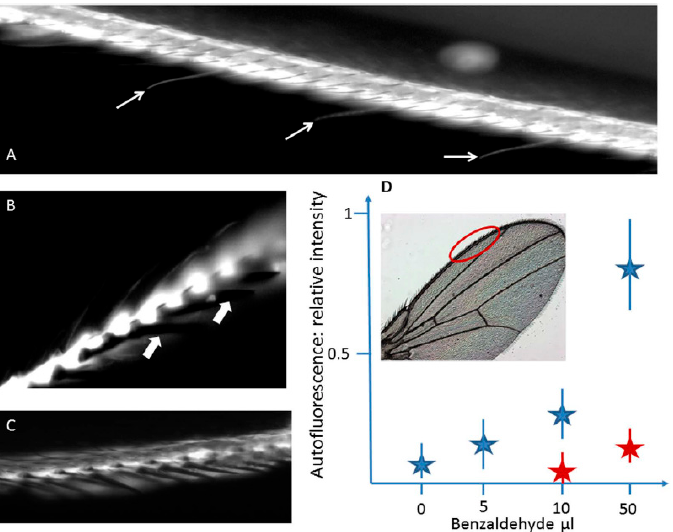
Figure 5. Treatment with volatile benzaldehyde results in the appearance of strong fluorescence emission in the regions of the wing of Drosophila corresponding to ( A ) the anterior margin of the vein, where also chemosensory sensilla are labelled (arrows), and ( B ) the chemosensory hairs, contrarily to the mechanoreceptors bristles (arrows). ( C ) In a cut wing subjected to the same treatment, the margin vein is labelled, contrarily to the thin chemosensory hairs. ( D ) Fluorescence intensity response in flies after a two-hour exposure to benzaldehyde at increasing concentrations, in live samples (blue stars; n = 10) or on cut wings (n = 5) treated under the same conditions (red stars). Modified from [67].